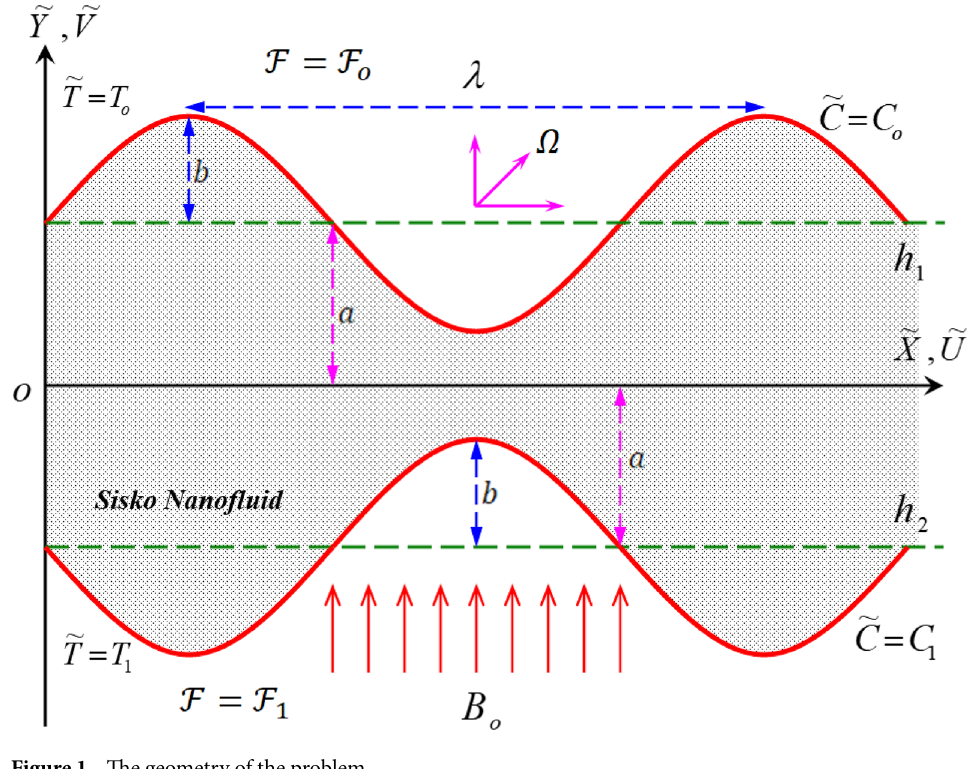
Figure 1. The geometry of the